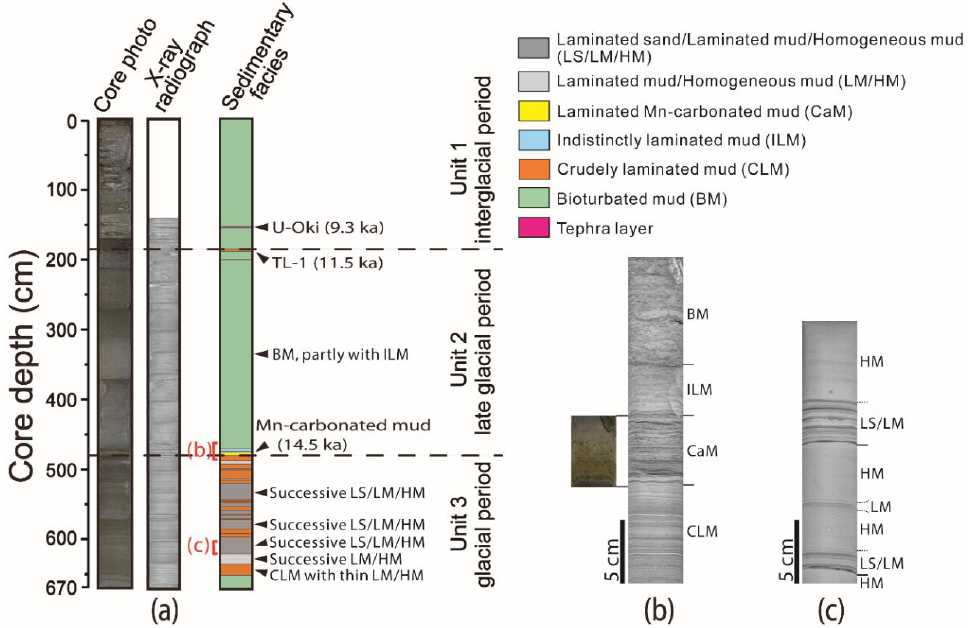
Figure 2. The Sedimentary Facies of DPC1801. Unit 1 is the interglacial period (0–188cm), Unit 2 is